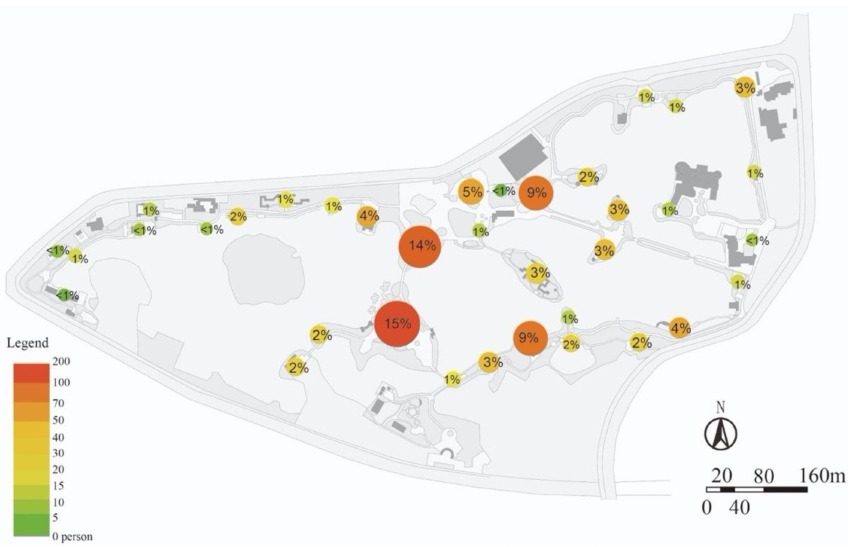
Figure A6. Spatial distribution of average total number of users per hour in Liuhuahu